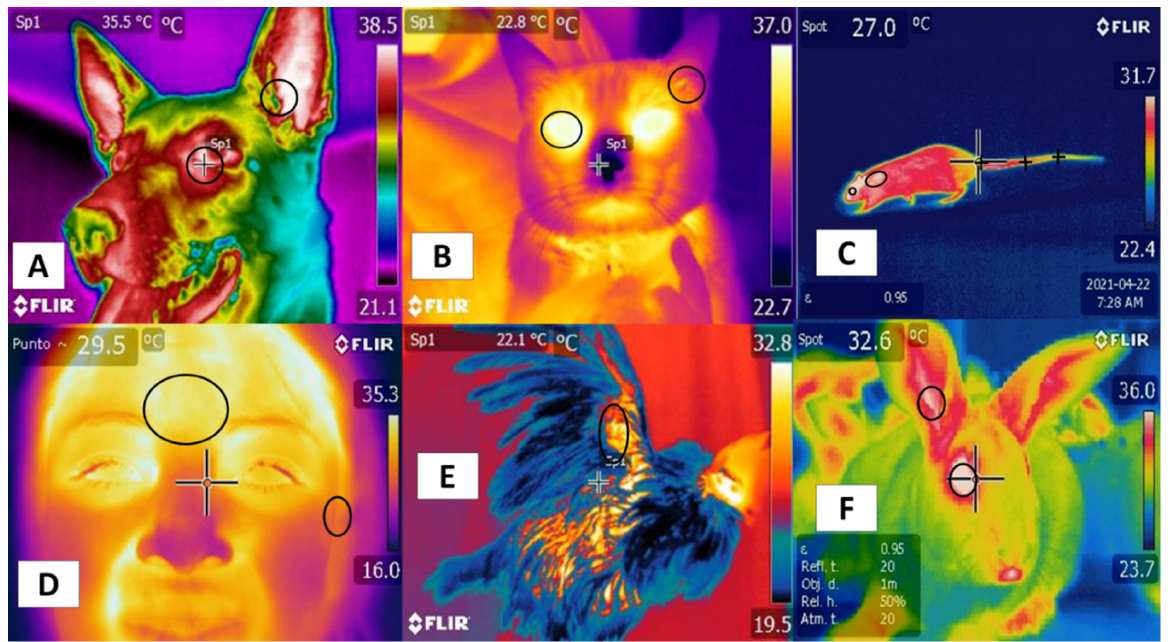
Figure 2. Thermal windows used in different species. ( A ) in dogs, the lacrimal caruncle in the orbital region ( regio orbitalis ) and the auricular pavilion of the ear in the auricular region ( regio auricularis ); ( B ) in cats, the eye in the orbital region ( regio orbitalis ) and the auricular pavilion of the ear in the auricular region ( regio auricularis ); ( C ) in rats, the orbital region ( regio orbitalis ), the interscapular region, and the base of the tail in the tail region; ( D ) in humans, the frontal region and the auricular pavilion of the ear in the auricular region ( regio auricularis ); ( E ) in hens, the radial region; ( F ) in rabbits, the orbital region ( regio orbitalis ) and the auricular pavilion of the ear in the auricular region ( regio auricularis ). Identification of different thermal windows has been achieved for most